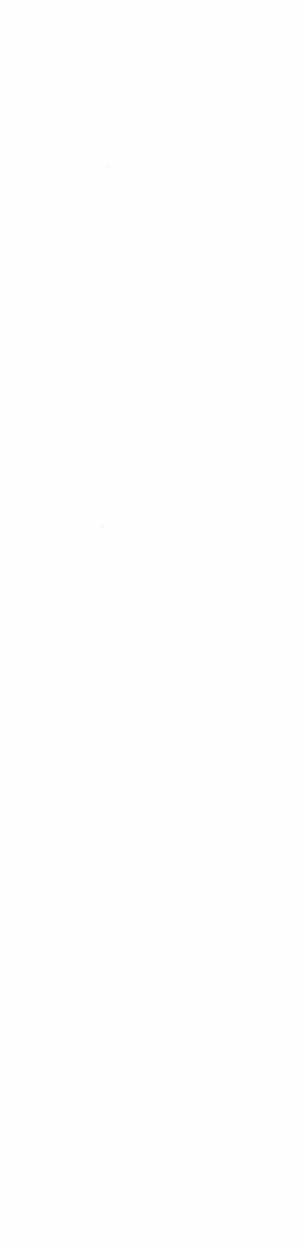
Fig. 4: Stress-strain curve